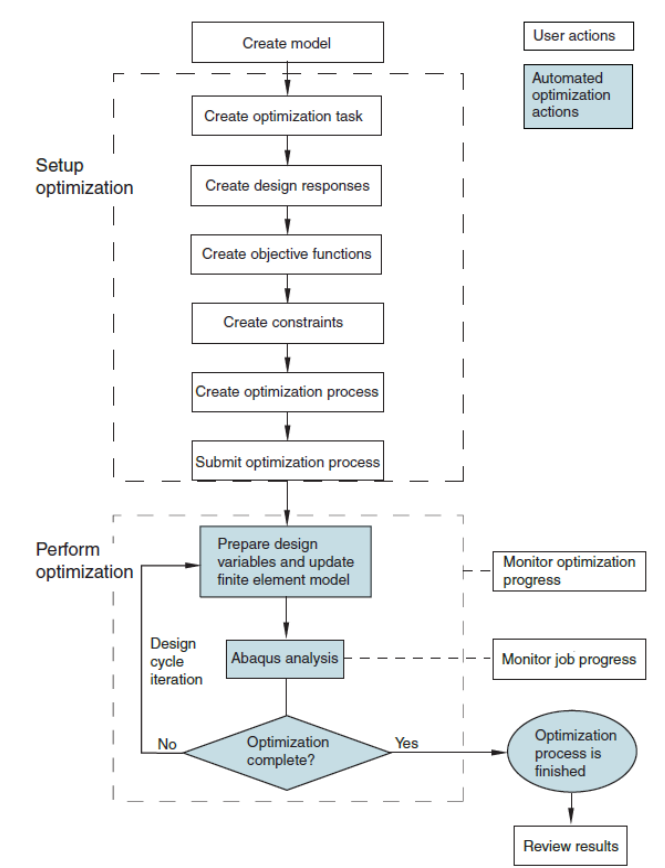
Figure 4. Flowchart of the optimization